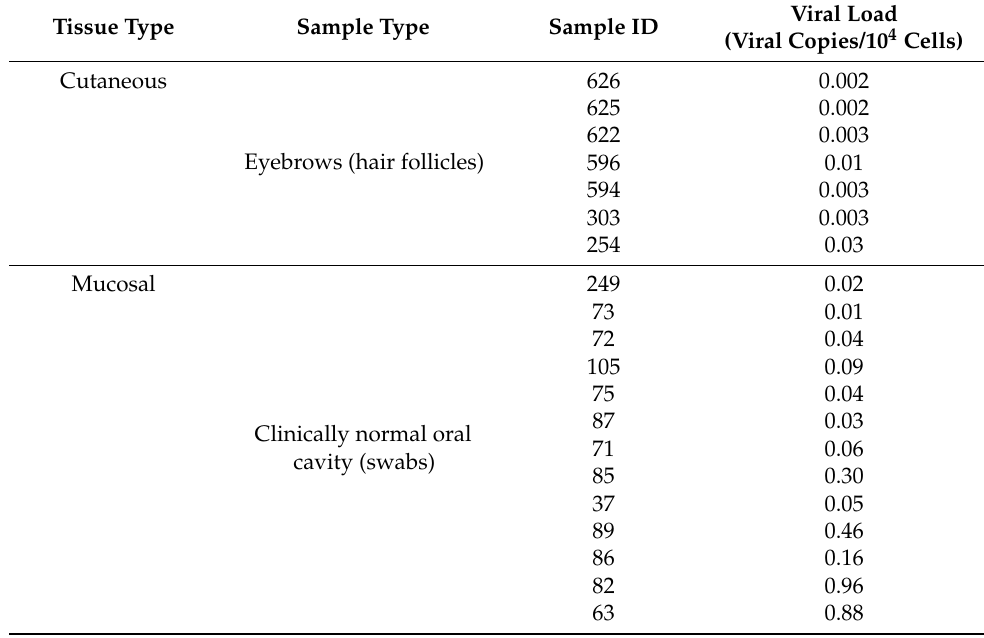
Table 3. Viral load in HPV159-positive eyebrow hair follicles and the oral